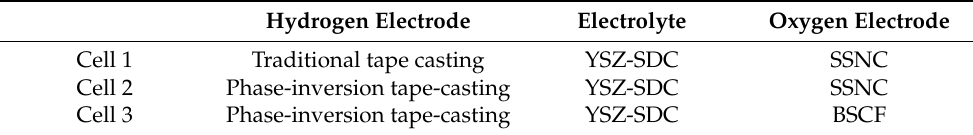
Table 1. The various parameters of SOCs in this study.